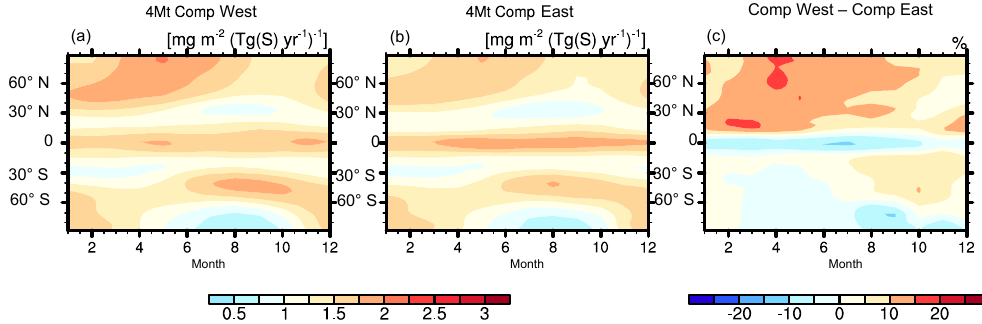
Figure 6. Zonal and multi-year monthly means of normalized sulfate burden [mgm − 2 ( Tg ( S ) yr − 1 ) − 1 ] o simulation 4Tg60 plotted as Hov- møller diagram. (a) : Composite West, (b) : Composite East, and (c) : the difference of both in